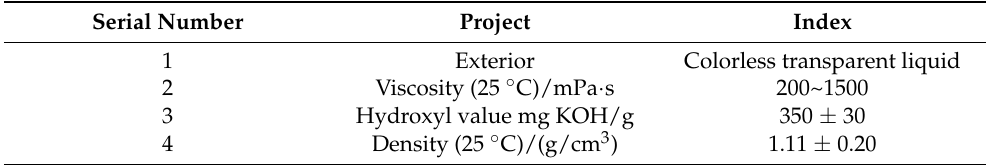
Table 3. ES305 Physical and Chemical Properties.